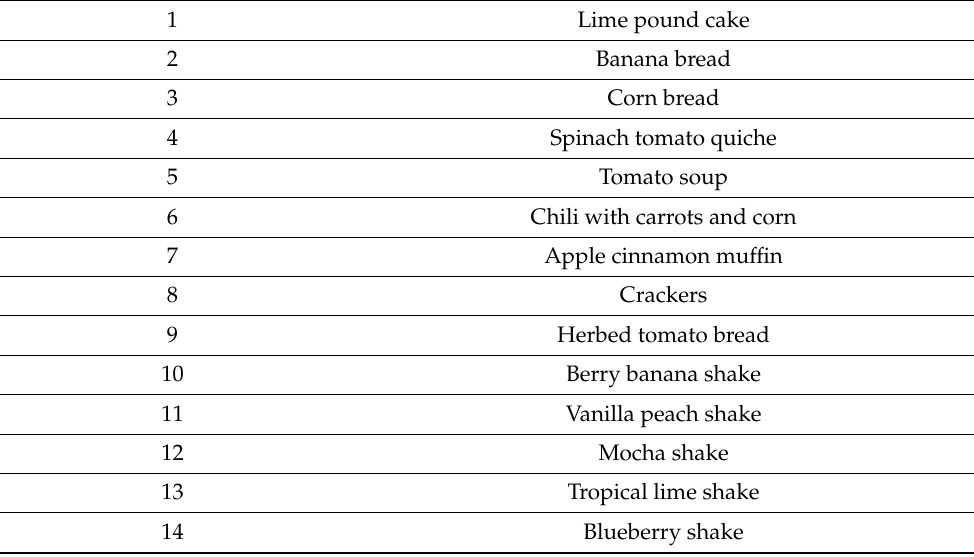
Table 2. List of foods each containing 5 g of whole green soybean flour